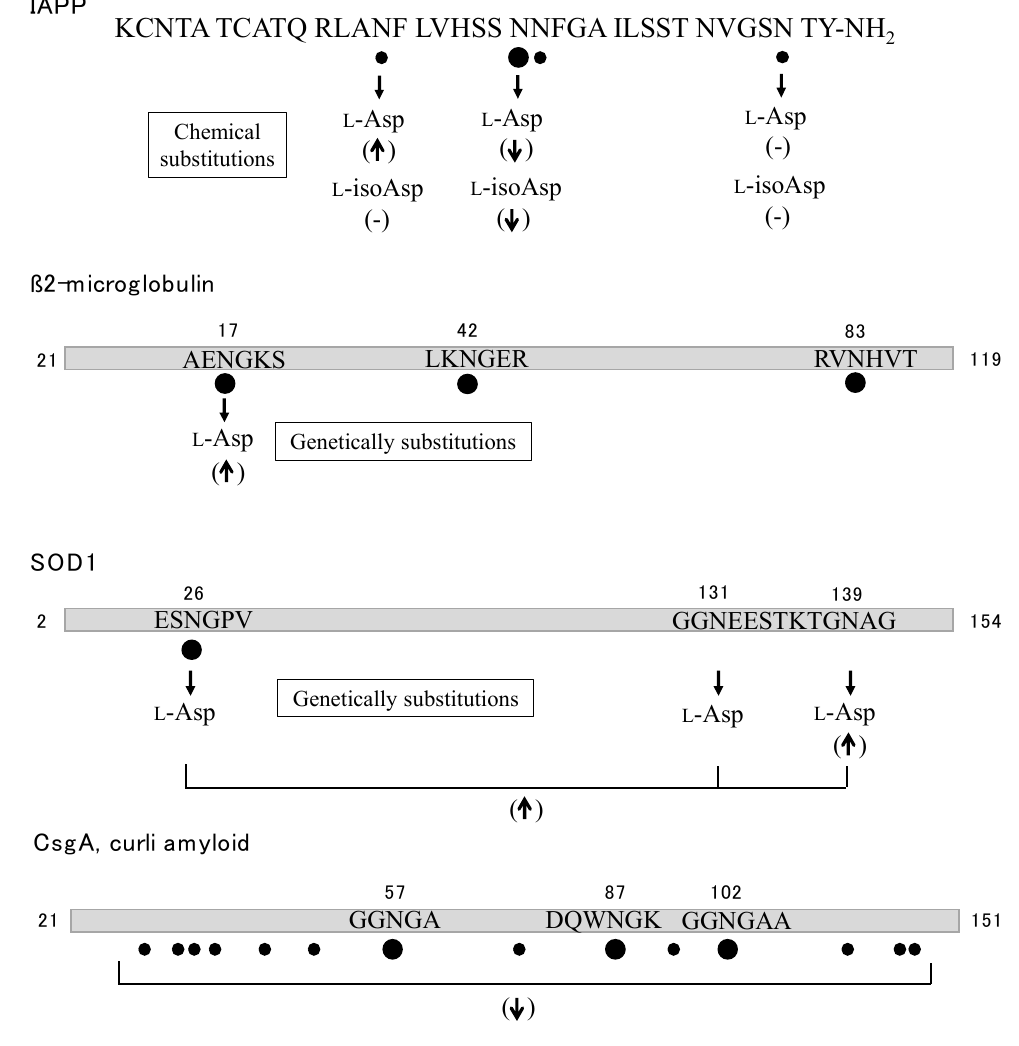
Figure 7. Summary of deamidation and isomerization in IAPP [112–115], β2-Microglobulin [116–118], SOD1 [119] and curli amyloid [120]. Asn deamidation and Asp isomerization are indicated by closed circles and open circles, respectively. The relationship between Asn substitution and fibril formation is also shown. ( ↑ ) acceleration or increase of fibril formation, ( ↓ ) suppression or decrease, (-) little or no effect.